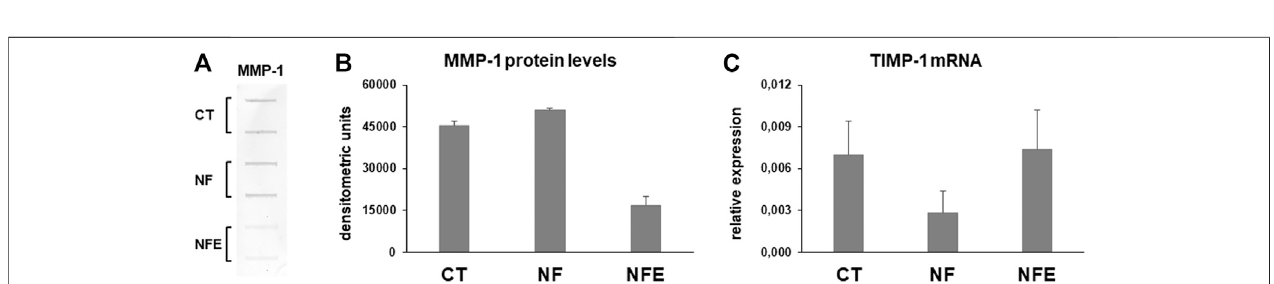
FIGURE 6 | (A) Representative slot blot for MMP-1 levels assayed by slot blot in serum-free cell supernatants of HGF cultured in the considered experimental settings. (B) Bar graphs showing MMP-1 protein levels after densitometric analysis of immunoreactive bands. Data are expressed as mean ± SD for at least